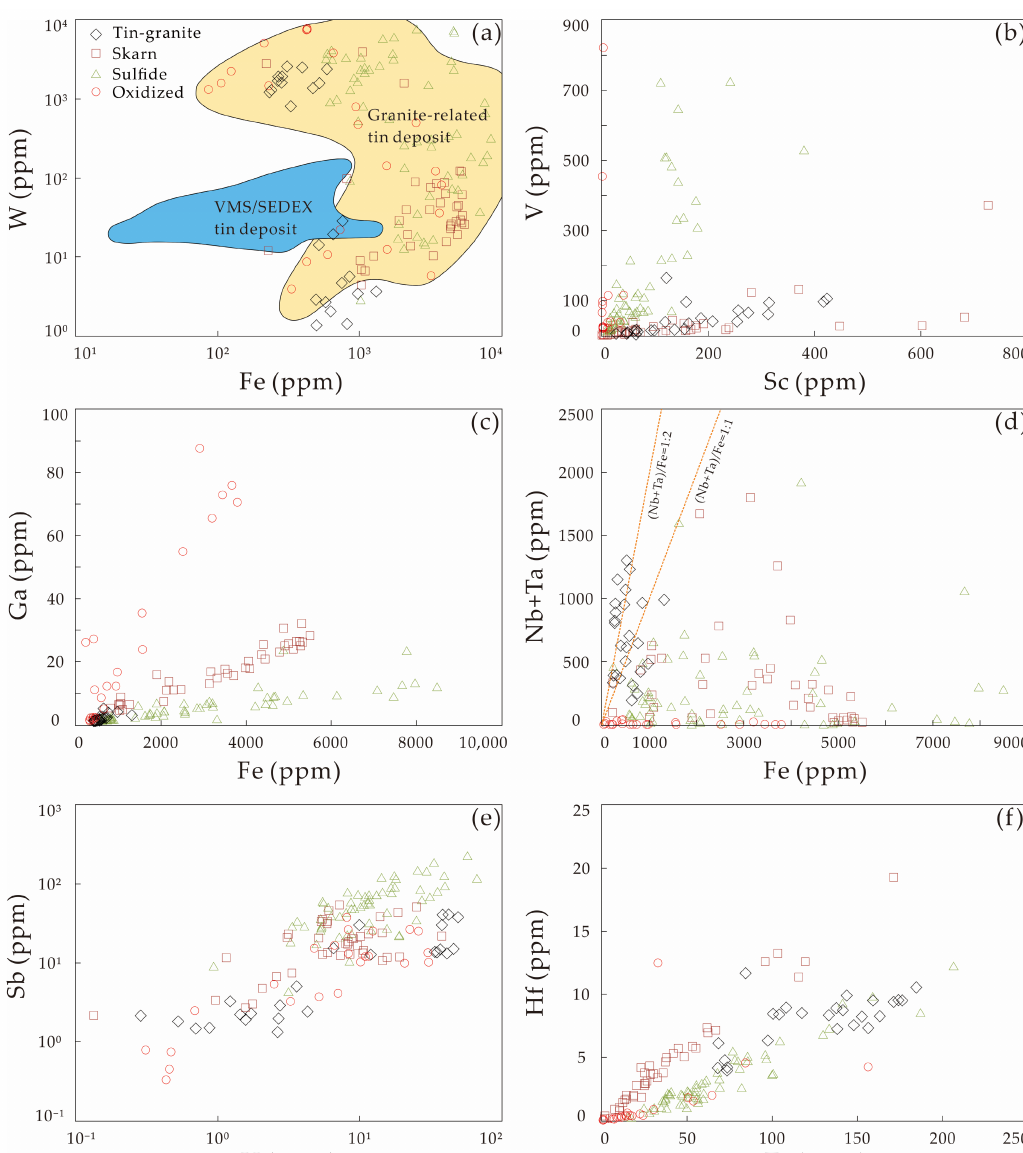
Figure 7. Correlation binary plots of selected trace elements in cassiterite samples from the Gejiu tin polymetallic deposit. ( a ) The plot of W vs. Fe displays that the tin mineralization is related to granitic magmatism; ( b , c ) The plots of V vs. Sc and Ga vs. Fe display a clear positive correlation; ( d ) The plot of Nb+Ta vs. Fe displays cassiterite from tin-granite have a (Nb + Ta)/Fe ratio near 1; ( e , f ) The plots of Sb vs. U and Hf vs. Zr display a positive